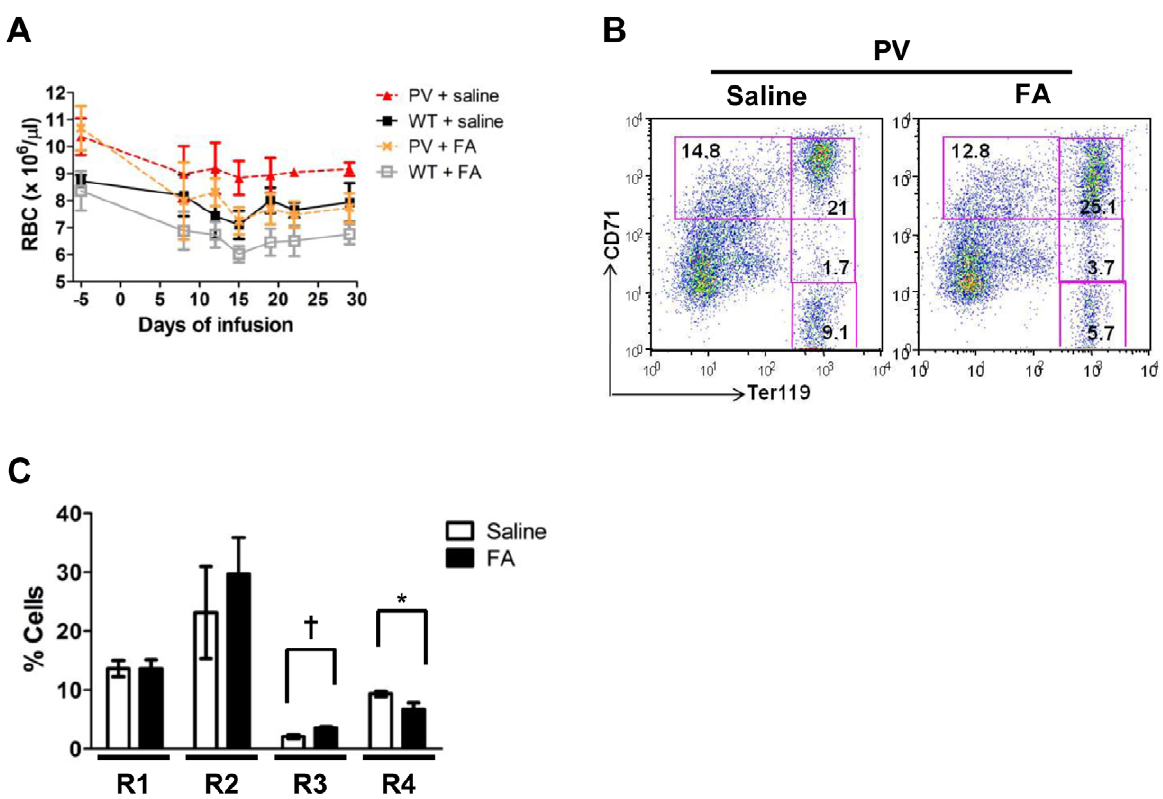
Figure 8. Aconitase inhibition normalizes red cell counts in a murine model of polycythemia vera. ( A ) RBC values over the course of a four-week infusion of saline (0.9%; n=3) or FA (2 mg/kg/day; n=10). Data represent mean 6 SD. ( B ) Erythroid maturation in day 28 PV marrows. Boxes indicate erythroid developmental stages R1–R4. ( C ) Summary of data from panel B with mean percentages of cells in R1–R4 6 SD; n=3 per group; * P , 0.05; { P , 0.01.